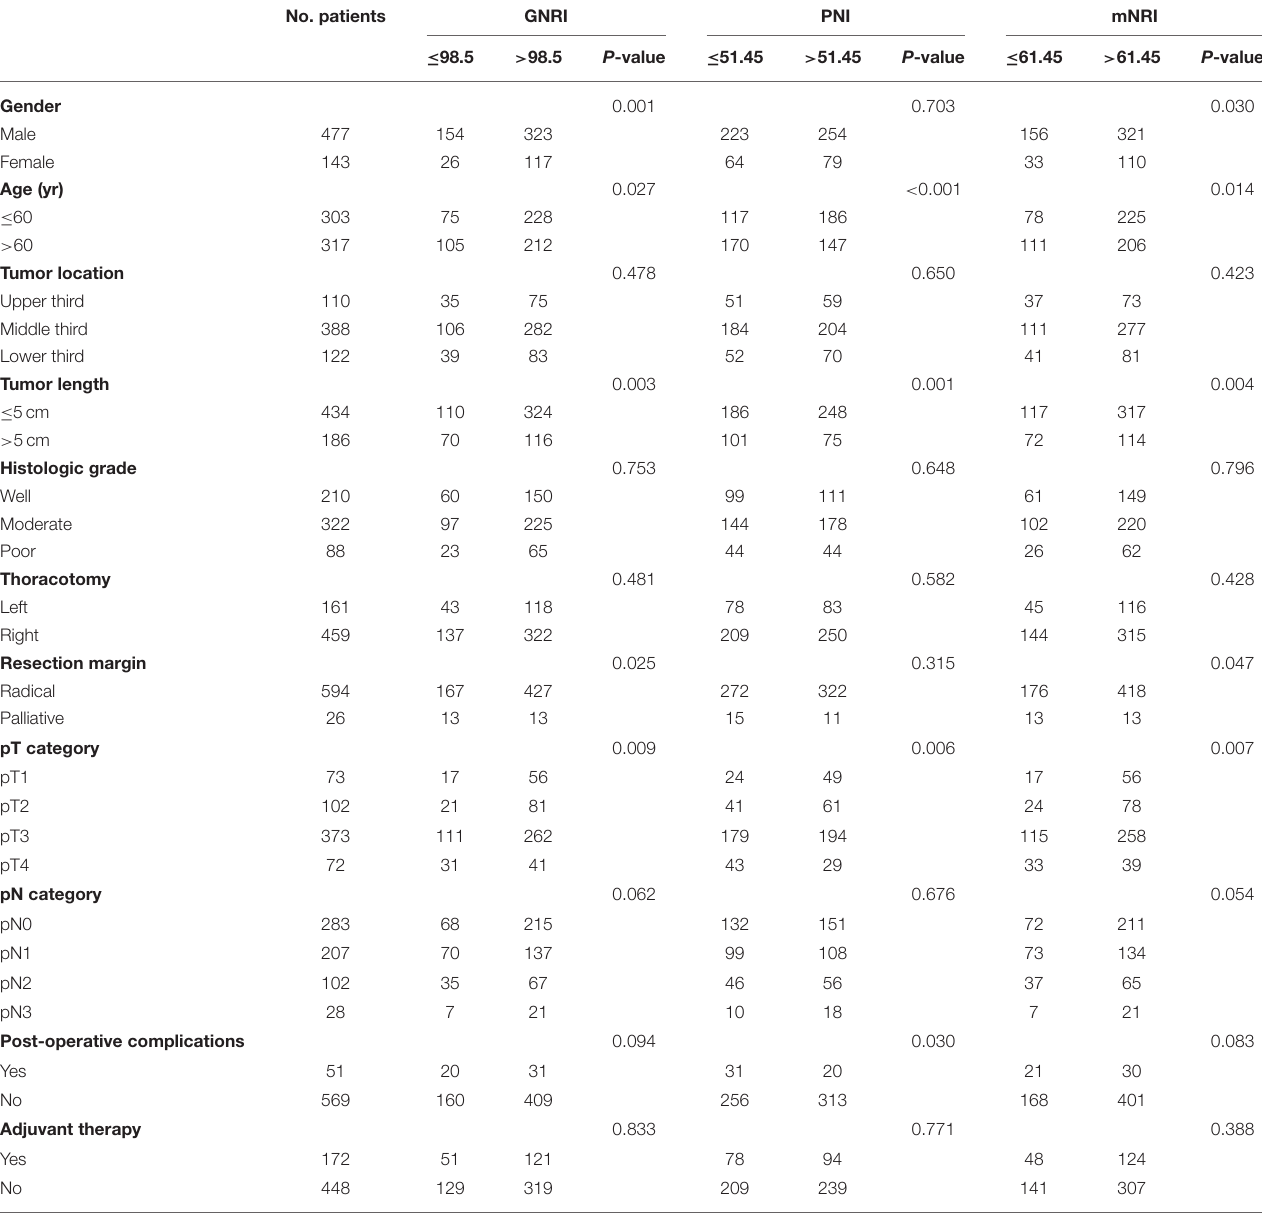
TABLE 2 | Correlation of the GNRI, PNI, and mNRI with the clinicopathological